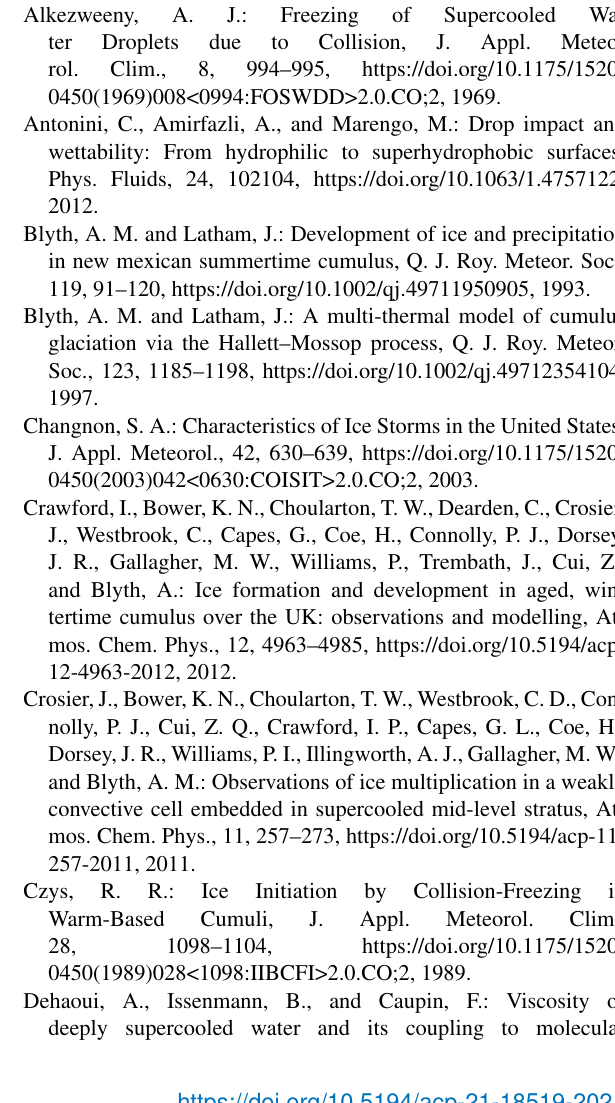
Table A2. The mean ( (cid:56) ) and standard deviation (SD) of the fraction of frozen secondary drops within a specified temperature interval ( T interval) along with the number of experiments ( n ) within the T interval, the average degree of supercooling within the temperature interval ( T ) and the error in the sample mean ( σ